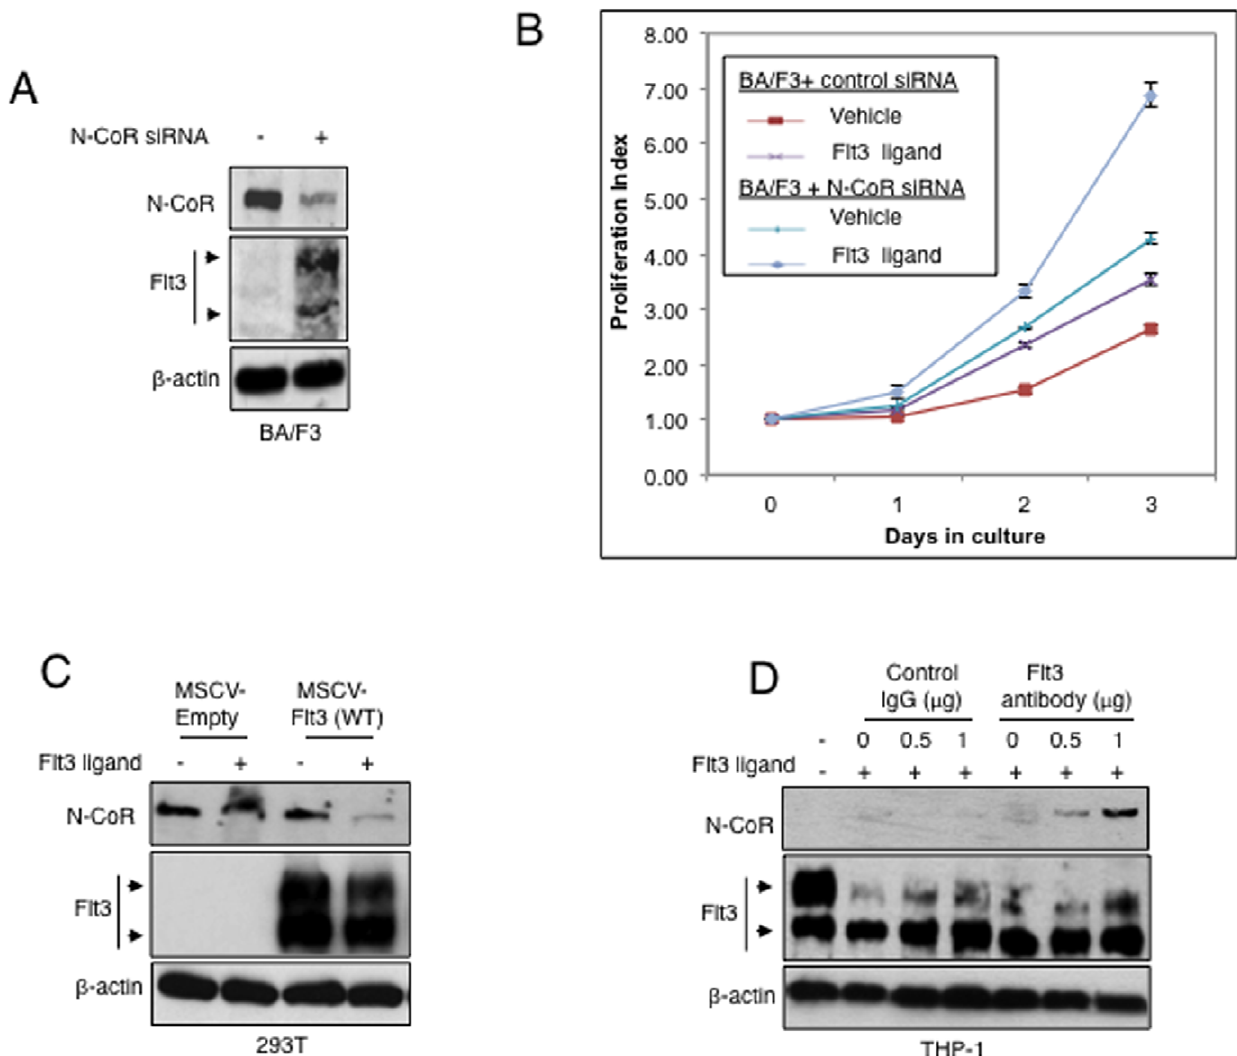
Figure 4. N-CoR loss promotes growth potential, which is amplified by Flt3 signaling activation. A , Levels of N-CoR and Flt3 protein in Ba/F3 cells transfected with control or N-CoR siRNA were determined via western blotting assay with an anti-Flt3 antibody that recognizes the murine form of the receptor and anti-N-CoR antibody. B , N-CoR loss mediated Flt3 expression enhanced the IL-3 independent growth potential of BA/F3 cells. Effect of IL-3 independent growth of Ba/F3 cells transfected with control or N-CoR siRNA (population from 4A) with and without Flt3 ligand stimulation were determined by cell proliferation assay. The Y-axis of the graph represents the proliferation index of viable cells, and the duration of culture is plotted on the X-axis. The symbols used in the graph are as follows: Control siRNA transfected cells treated with vehicle ( ), Control siRNA transfected cells stimulated with Flt3 ligand ( ), N-CoR siRNA transfected cells treated with vehicle ( ) and N-CoR siRNA transfected cells stimulated with Flt3 ligand ( ). The values presented in each graph are average of three independent experiments. C , Flt3 stimulation leads to N- CoR loss. Levels of N-CoR and Flt3 proteins in 293T cells treated with vehicle or Flt3 ligand (30 ng/ml) was determined by western blotting assay. D , Blocking Flt3 stimulation leads to N-CoR stabilization in THP-1 cells. Effect of Flt3 antibody on the levels of N-CoR and Flt3 proteins in THP-1 cells treated with vehicle or Flt3 ligand (30 ng/ml) was determined by western blotting